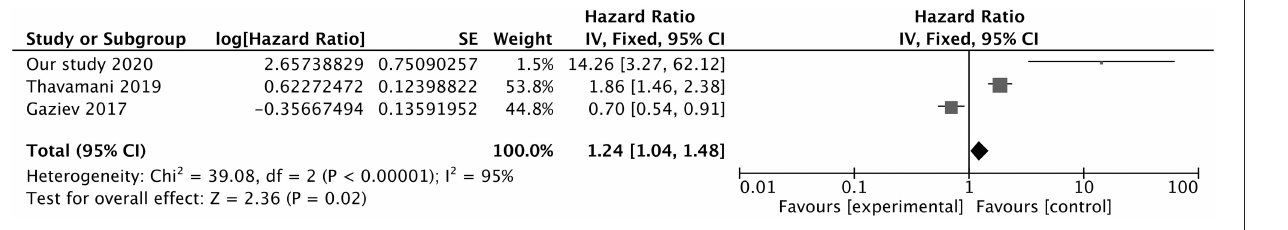
FIGURE 2 | Forest plot for incidence of